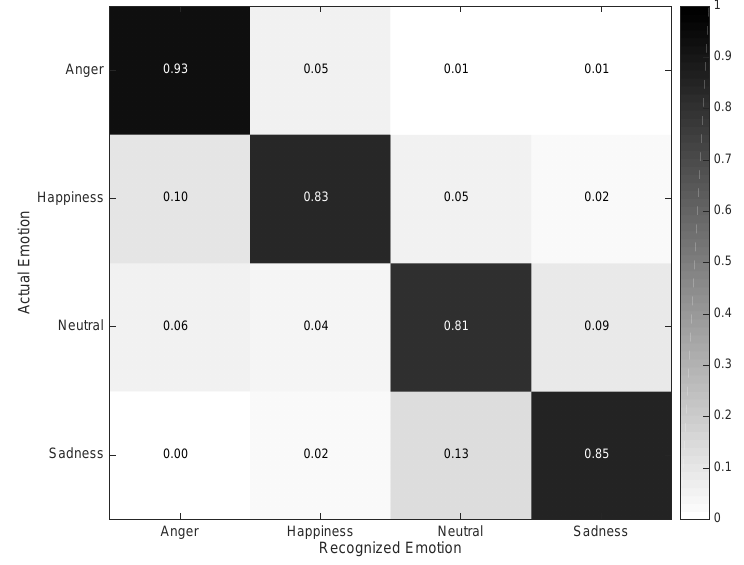
Figure 8. Confusion matrix describing the performance of the Audio Emotion Recognizer.